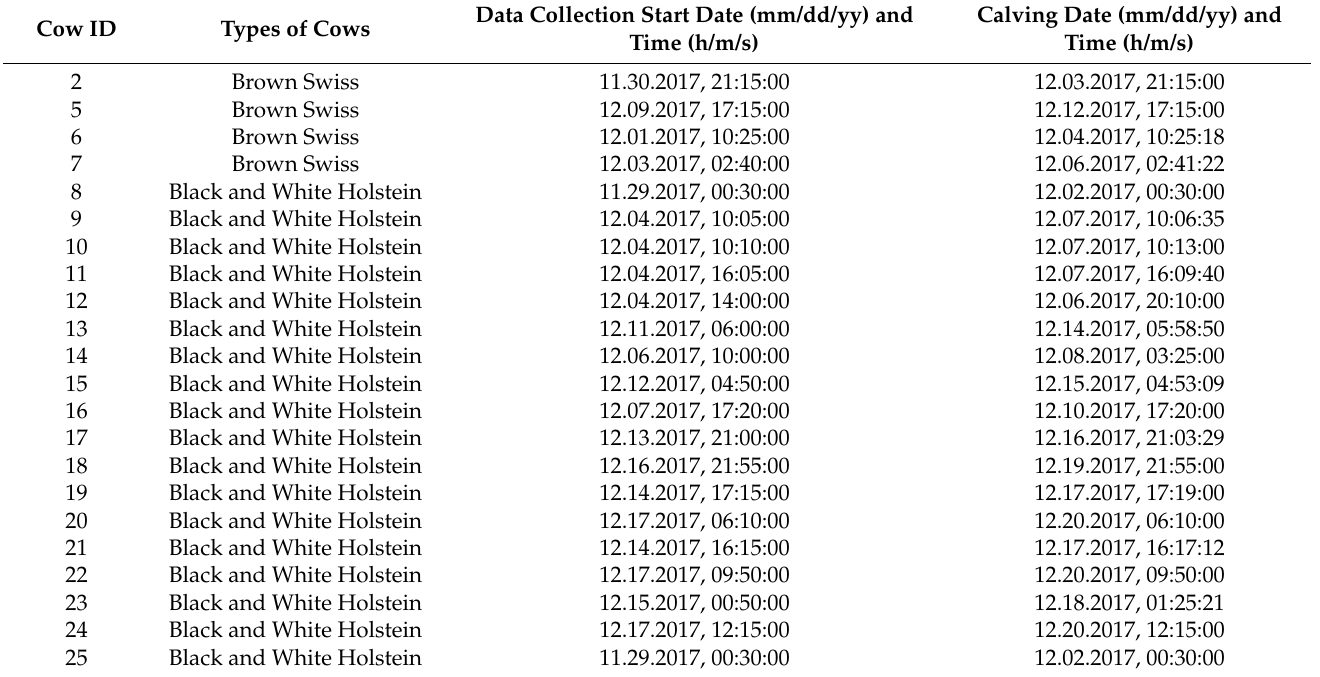
Table 2. Group 2: Multiparous pregnant cows data